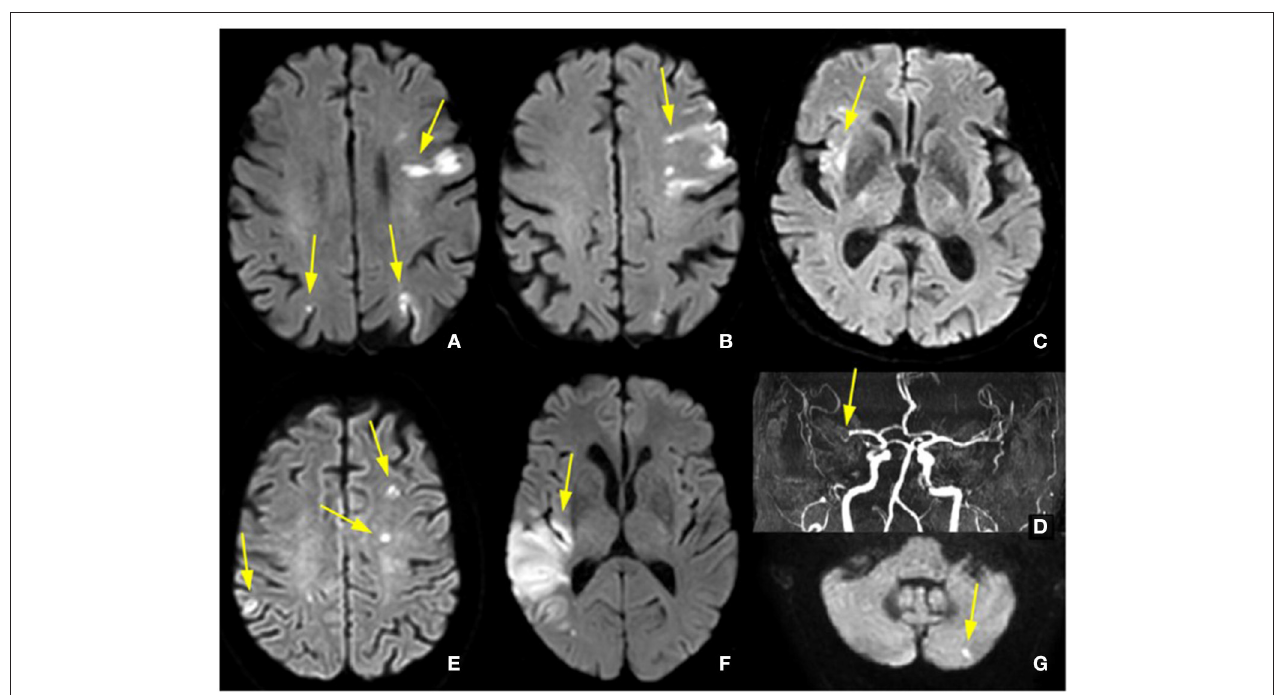
FIGURE 2 | Micro- and macrovascular lesions with the involvement of multiple territories. (A,B) Diffusion-weighted images showing multiple bilateral ischemic lesions (arrows) in patient 4; (C,D) Diffusion-weighted images showing recent right insular infarct with thrombus in the right middle cerebral artery in patient 2; (E-G) Diffusion-weighted images showing multiple microvascular and macrovascular lesions in patient